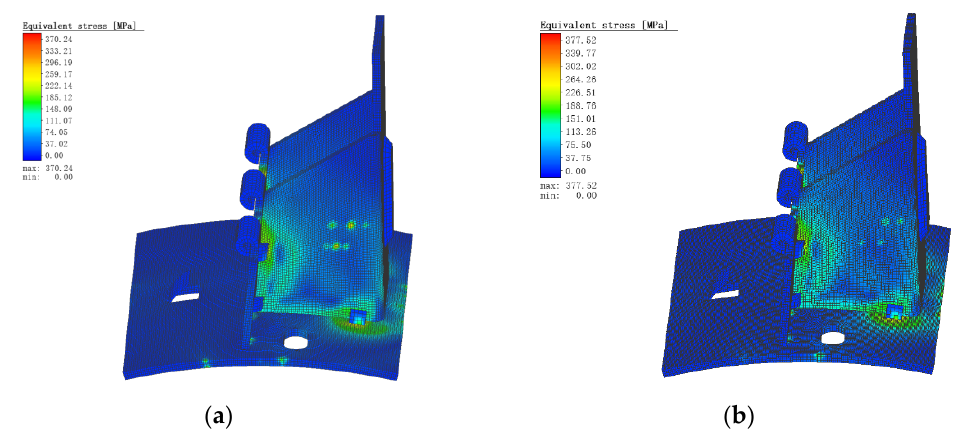
Figure 6. Equivalent stress diagram under the condition of the single welding torch and bilateral symmetrical double welding torch. ( a ) Single welding torch; ( b ) bilateral symmetrical double welding torch.